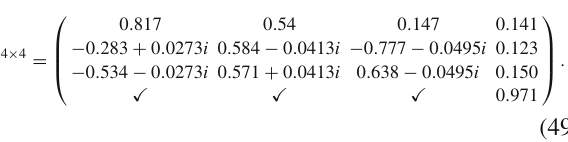
Fig. 7. If s 34 takes its value as given in Eq. (45), s 34 = 0 .